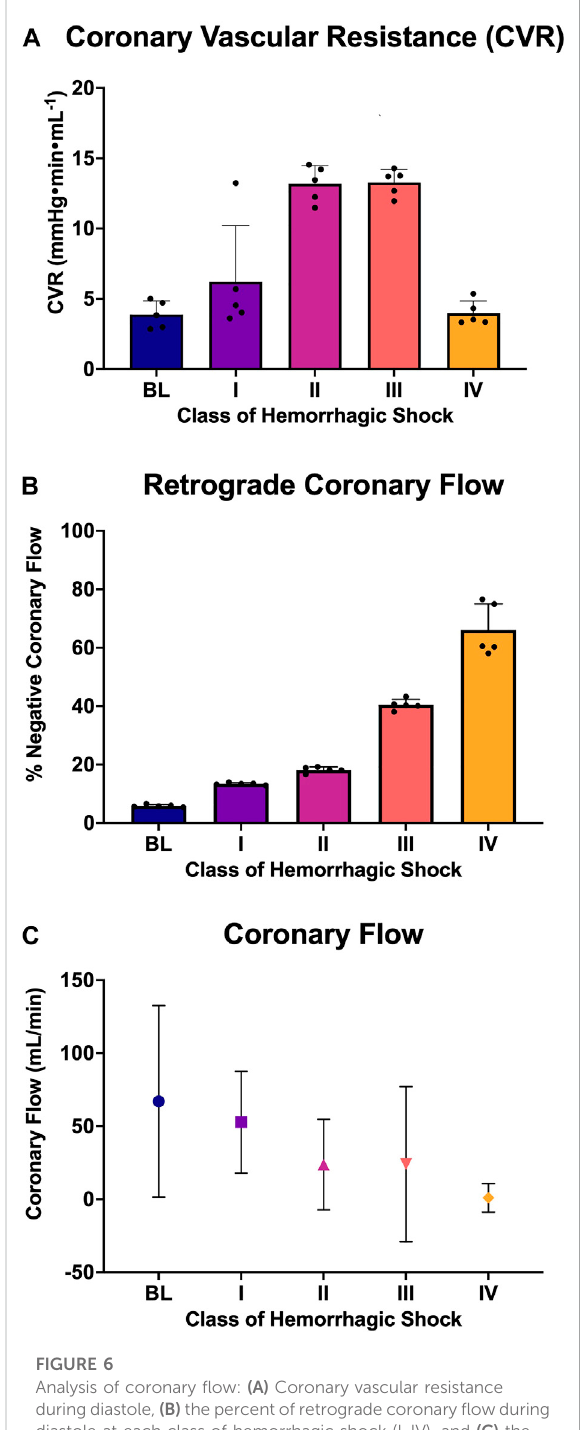
FIGURE 6 Analysis of coronary fl ow: (A) Coronary vascular resistance during diastole, (B) thepercentof retrograde coronary fl ow during diastole at each class of hemorrhagic shock (I-IV), and (C) the coronary fl ow(mL/min;meanandstandarddeviation)ateach class of hemorrhagic shock